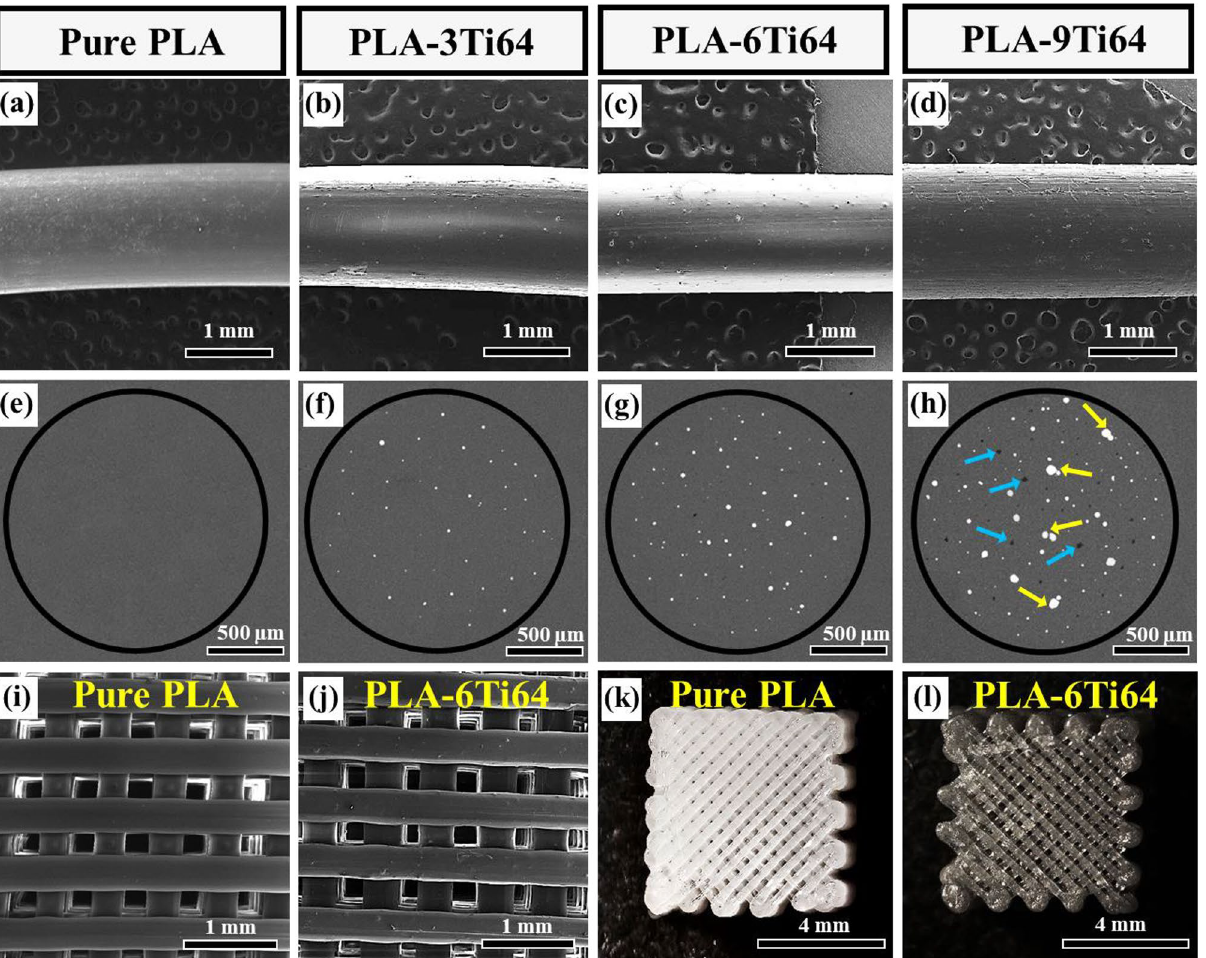
Figure 2. FESEM images showing the surface morphology ( a - d ) and cross-sectional views ( e – h ) of pure PLA ( a , e ), and composite filaments containing 3 wt% ( b , f ), 6 wt% ( c , g ), and 9 wt% ( d , h ) Ti64. Blue and yellow arrows in ( h ) are related to microvoids and agglomerations, respectively. FESEM with a secondary mode ( i , j ) and stereomicroscope ( k , l ) images of pure PLA ( i , k ) and PLA-6Ti64 ( j , l ) 3D-printed